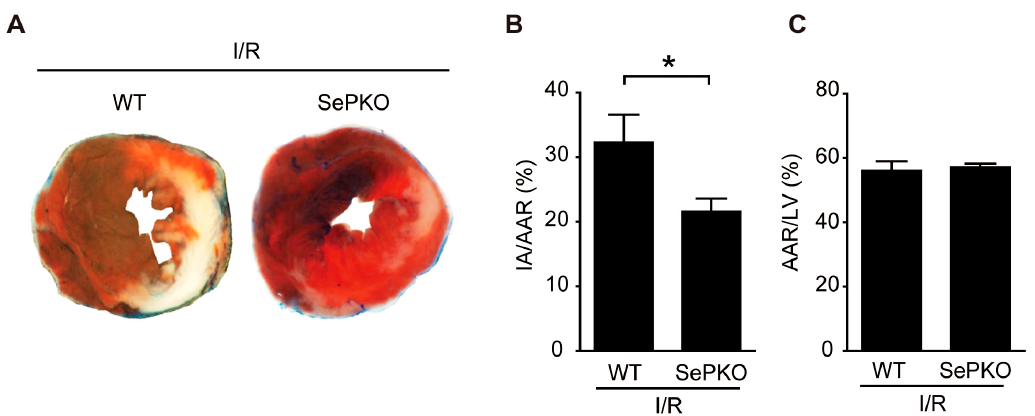
Figure 1. Selenoprotein P (SeP) knockout (KO) mice reduces I/R injury. SeP KO and control wild-type (WT) mice were subjected to 30 min of ischemia and 24 h of reperfusion. ( A ) Representative examples of myocardial infarction stained with Evans blue (EB) and triphenyl tetrazolium chloride (TTC) 24 h after reperfusion. EB-stained areas (blue) indicate non-ischemic regions; TTC-stained areas (red) indicate area at risk (AAR); EB/TTC-negative (white) areas indicate myocardial infarct area (IA). ( B ) The myocardial IA/AAR (percentage) is shown. ( C ) AAR/left ventricle (LV) size (percentage) is shown. Data represent means from at least five mice each. * p < 0.05.